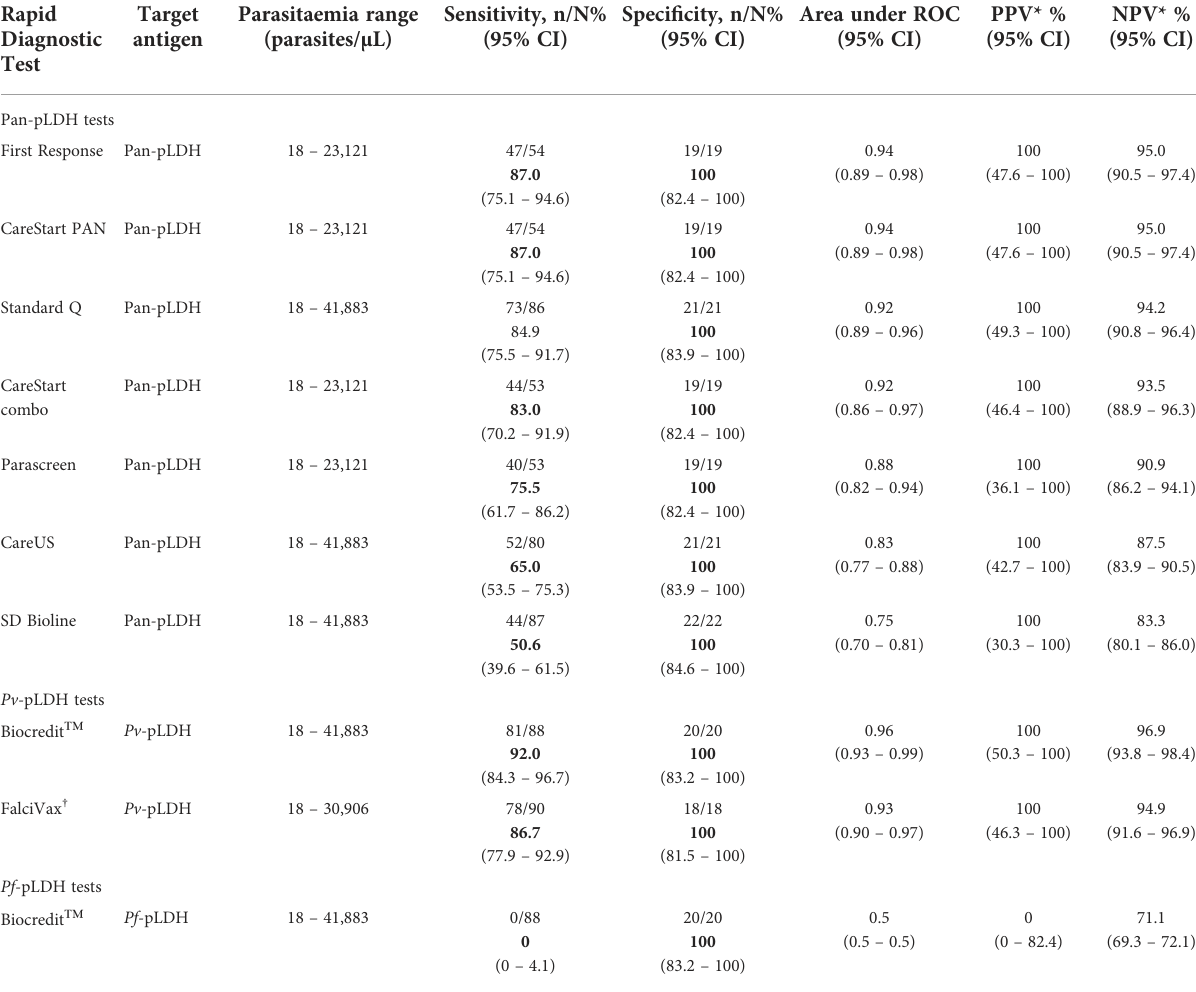
TABLE 2 Performance of RDTs in detecting P. knowlesi clinical infections (prior to antimalarial treatment). Rapid